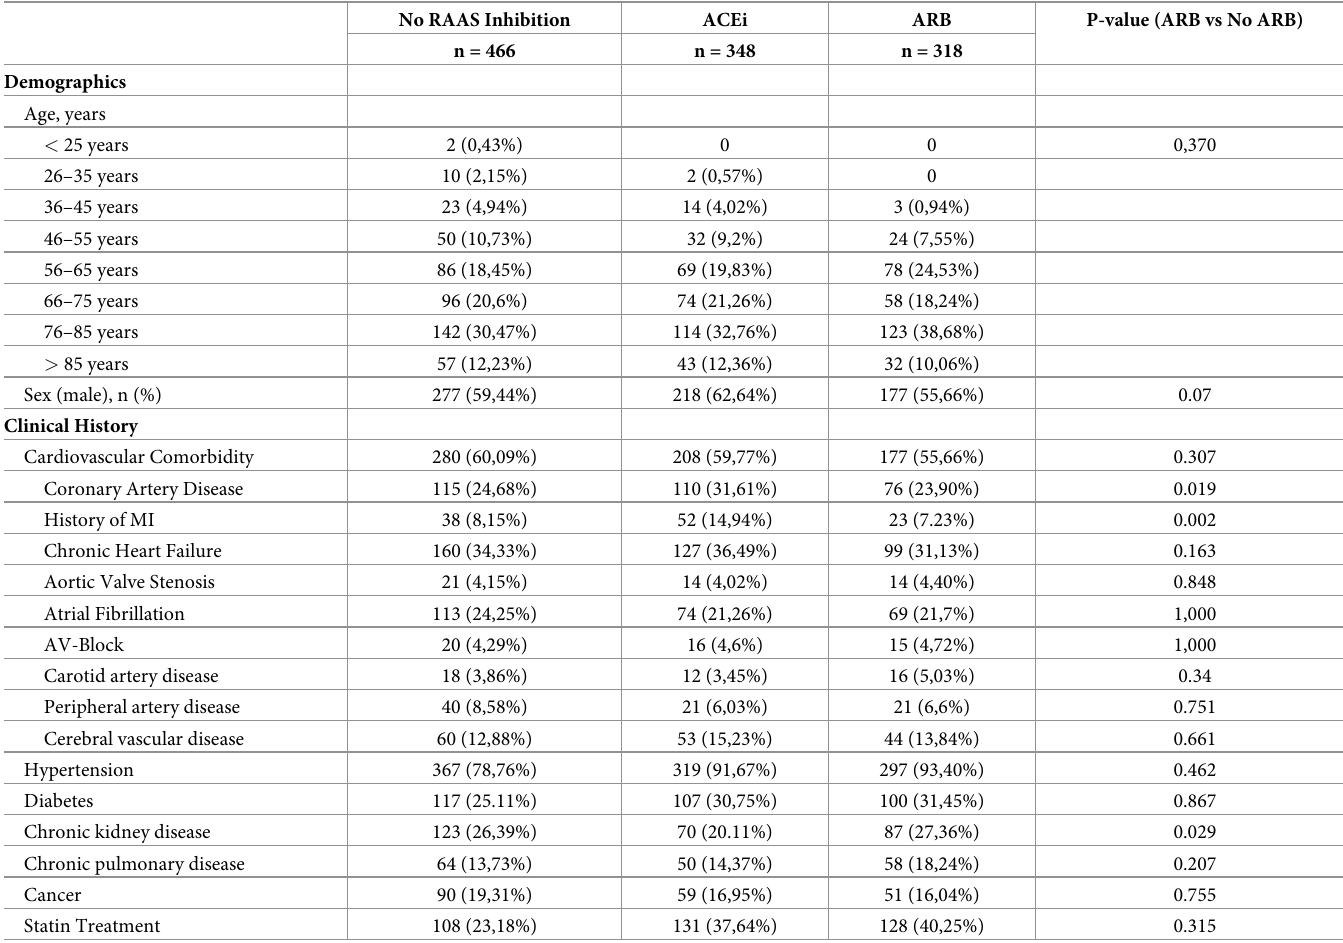
Table 2. Baseline characteristics of patients in the uncomplicated phase of